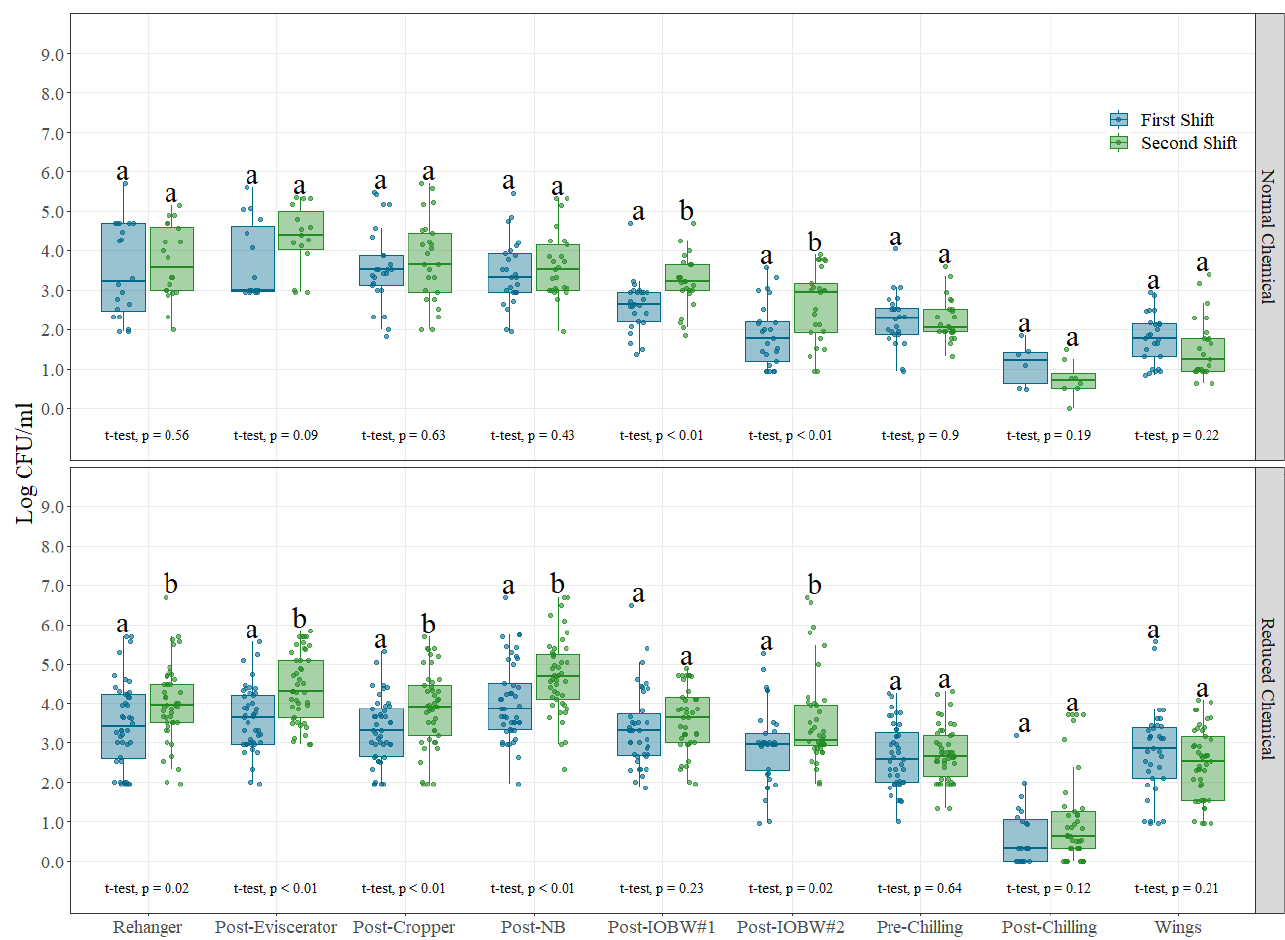
Figure 1. Enterobacteriaceae counts (Log CFU/mL) on each of the nine sampling locations under normal process interventions ( above ) and reduced chemical process interventions ( below ) on chicken and part rinses collected during different shifts. In each boxplot, the horizontal line crossing the box represents the median, the bottom and top of the box are the lower and upper quartiles, the vertical top line represents 1.5 times the interquartile range, and the vertical bottom line represents 1.5 times the lower interquartile range. (a,b) For normal and reduced chemical interventions at each sampling locations, boxes with different letters are significantly different according to t -test analysis at p < 0.05. The points represent the actual data points.